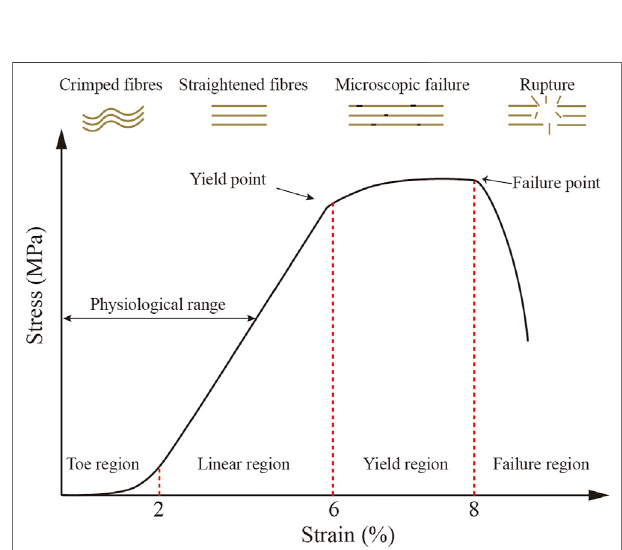
FIGURE 2 | Typical tendon stress and strain curves and a schematic diagram of collagen fi ber behavior. Four diverse regions may be observed. (1) Toe region ( < 2% strain), where fi bers are crimped; (2) linear region (2% – 6% strain), where fi bers are straightened; (3) yield region (6% – 8% strain), when microscopic failure is produced; and (4) failure region ( > 8% strain), where rupture is produced. (1) and (2) regions are regarded as physiological range, as previously described (Ruiz-Alonso et al.,